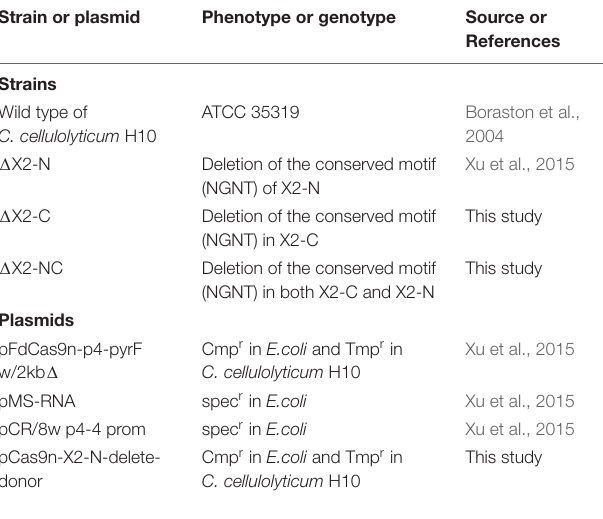
TABLE 1 | List of plasmids and strains used in this